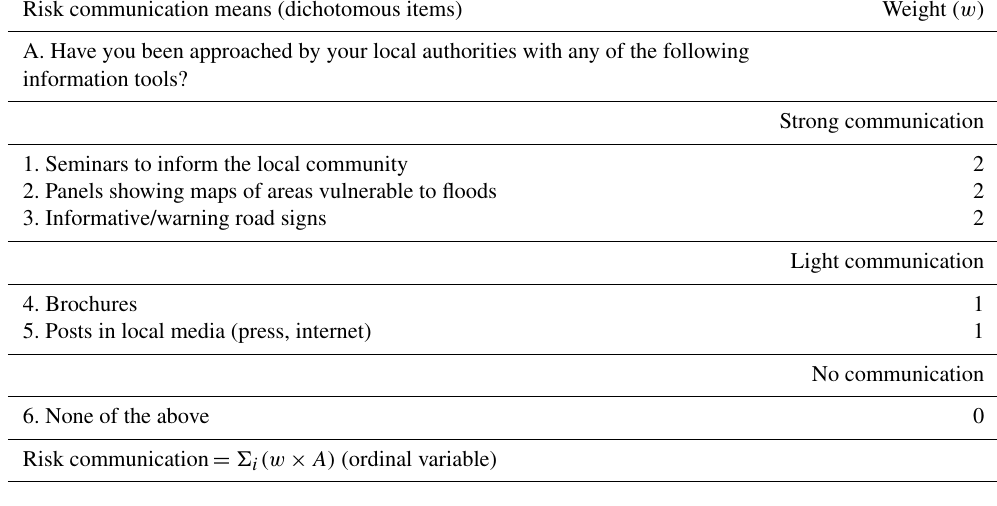
Table 4. Risk communication: items, adjusted weights, and model variable. Risk communication means (dichotomous items)